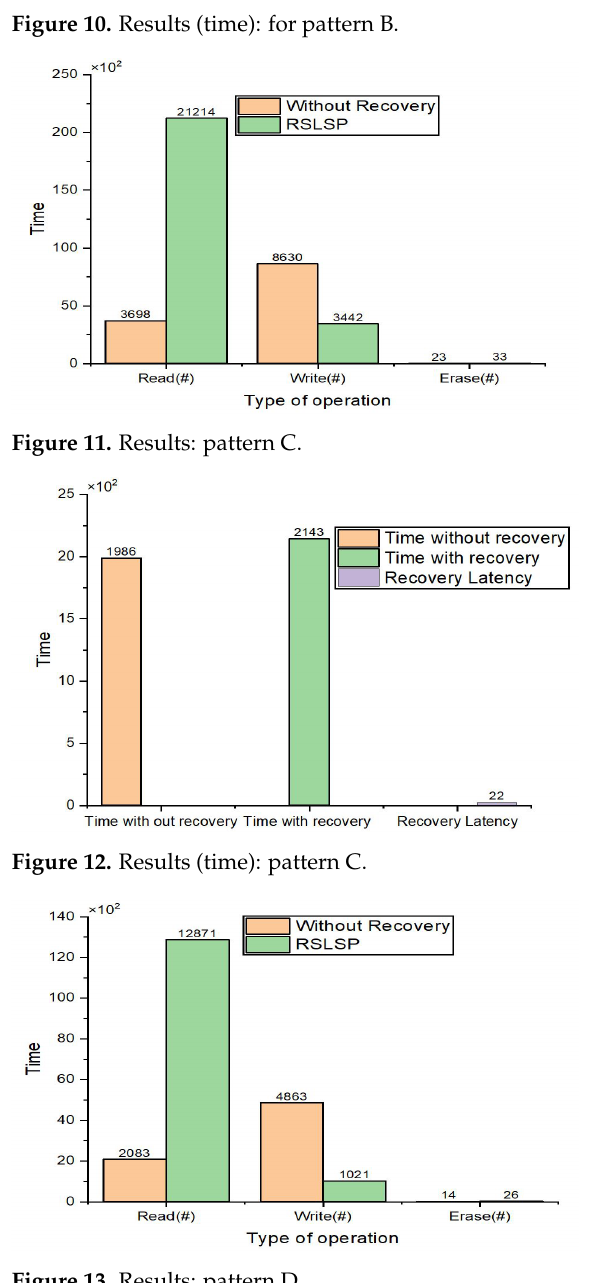
Figure 13. Results: pattern